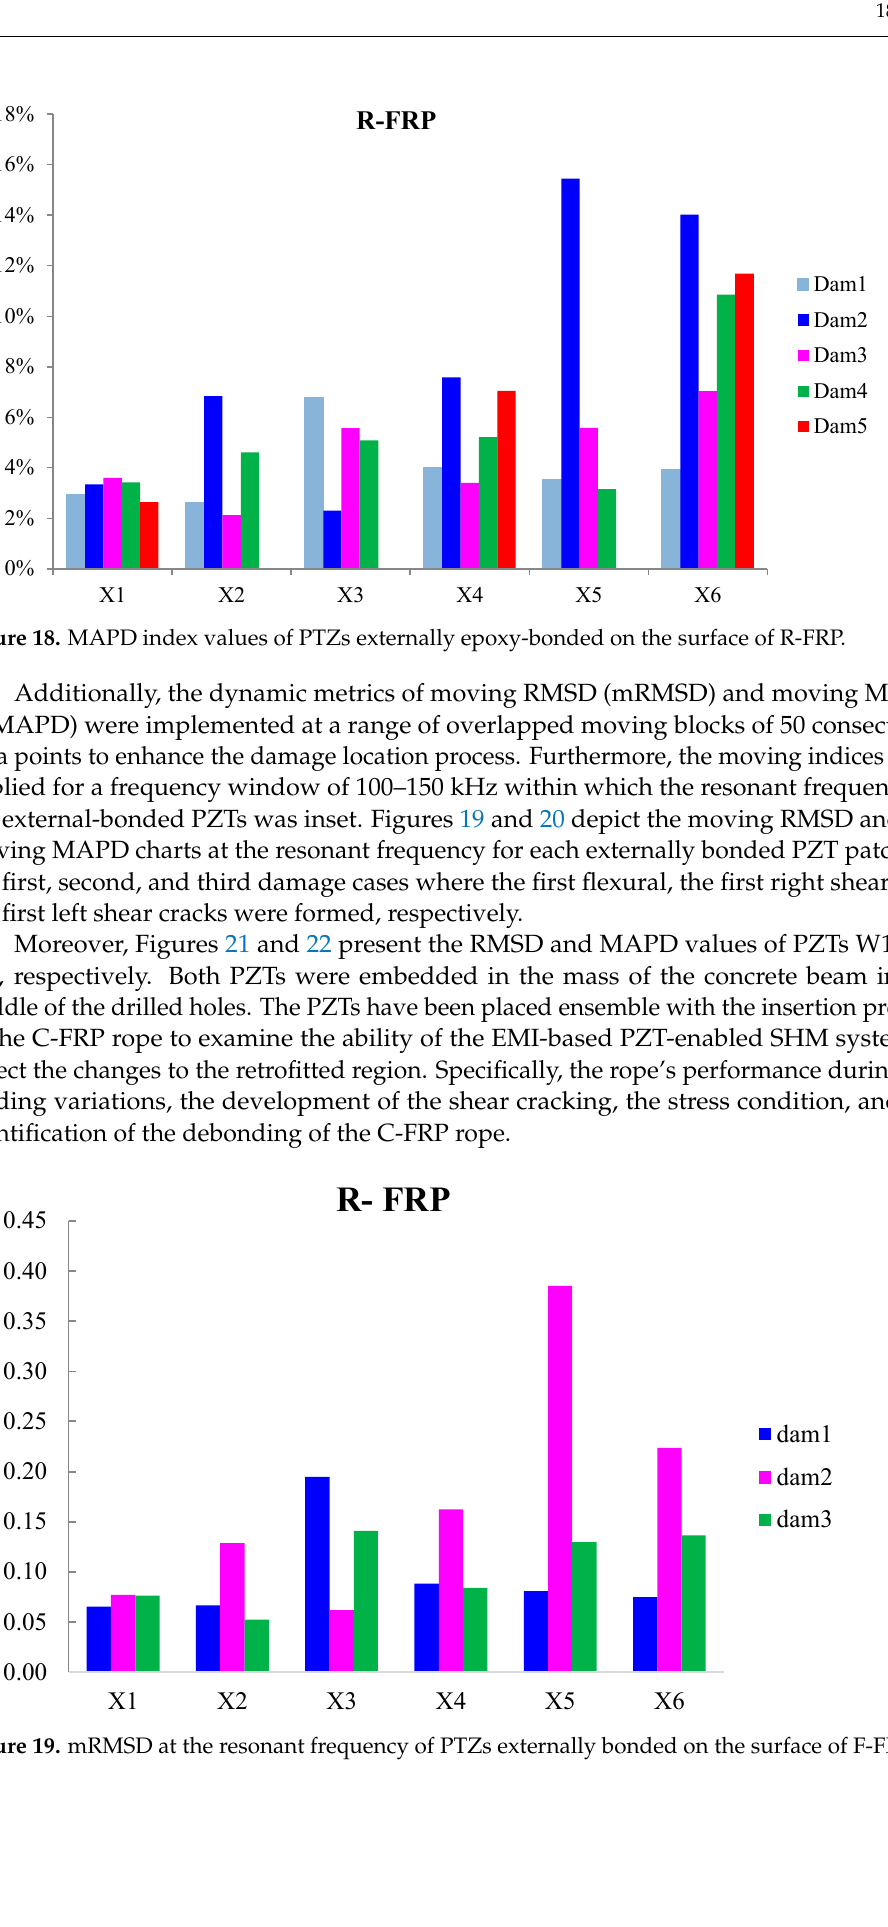
Figure 20. mMAPD at the resonant frequency of PTZs externally bonded on the surface of F-FRP. As presented in Figures 21 and 22 both PZTs showed results relative to the mechan- ical performance of each inserted rope electro-mechanical response. Regarding PZT W2, which monitored the diagonal inserted rope W2, the indices’ values follow precisely the mechanical response of the rope, which contributed as a shear resistance mechanism to restrain the shear failure. As a result, the more the C-FRP rope was subjected to tensional stresses, the more the indices’ values increased. Furthermore, PZT patch W1 showed the same trend, even in lower values, as the failure pattern near rope W1 was formed in more distributed cracks. Another parameter was that the rope’s direction was not vertically po- sitioned to the shear diagonal cracking, so a proportionally lower load was transferred as an applied force to the C-FRP rope compared to the C-FRP rope W2.